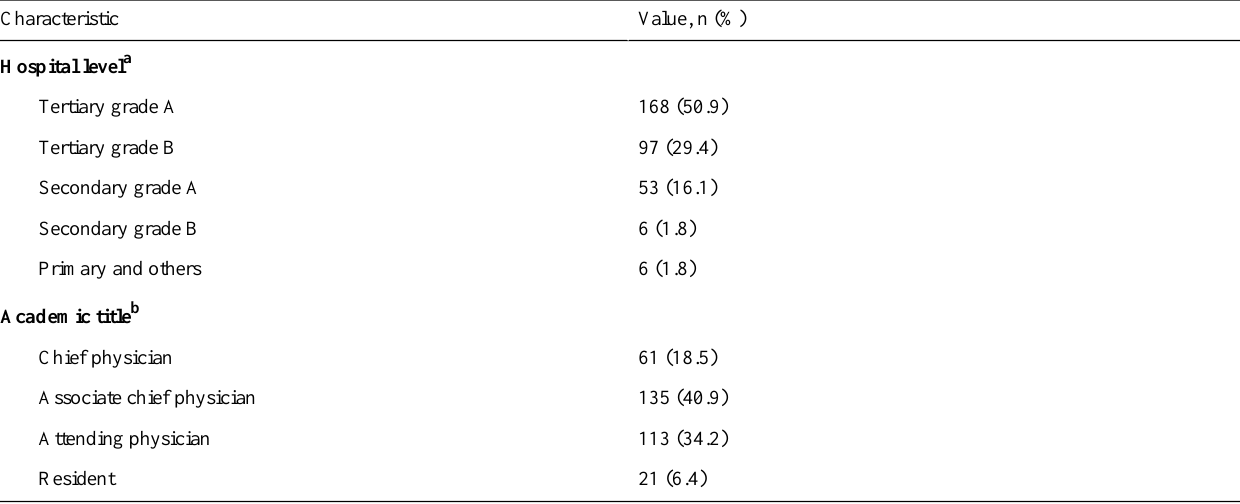
Table 1. Baseline information about the survey participants